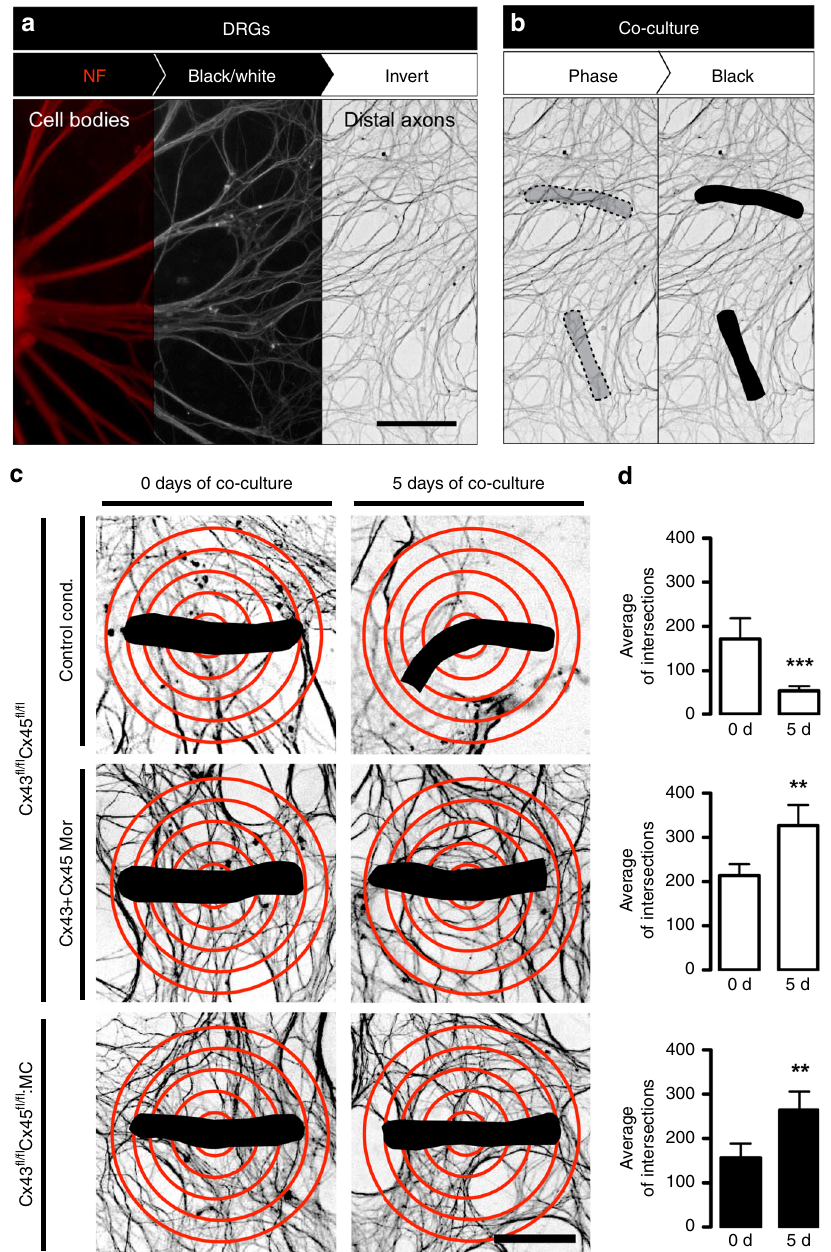
Fig. 7 The absence of Cx43 and Cx45 in cultured skeletal myo fi bers increases the number of axons around the myo fi bers in co-culture. a Immuno fl uorescence on DRGs using antibodies against neuro fi lament 200 (NF; red; left), converted to monochrome (black and white; middle), and inverted (white and black; right). Scale bar: 100 μ m. b Localization of myo fi bers in co-culture using phase-contrast images (dotted fi gure; left), converted to black images (dotted fi gure; right). c Quanti fi cation of the number of intersections between distal axons and 5 red concentric circles spaced at 15 μ m centered on the myo fi bers (black). DRGs co-cultured with myo fi bers from Cx43 fl / fl Cx45 fl / fl mice in control conditions (Control cond.; top row), or in presence of Cx43 + Cx45 Mor (middle row), and Cx43 fl / fl Cx45 fl / fl :MC mice (bottom row) at 0 days (right column), or 5 days (left column) of co-culture. Scale bar: 50 μ m. d Average of intersections. N = 5; at least 55 myo fi bers recorded in each independent experiment, each value is the mean ± SEM. The results obtained from Cx43 fl / fl Cx45 fl / fl mice are represented by white bars and from Cx43 fl / fl Cx45 fl / fl :MC mice by black bars. *** p < 0.001, and ** p < 0.005, for 5 days of co-culture compared with 0 days of co-culture, by Student ’ s t